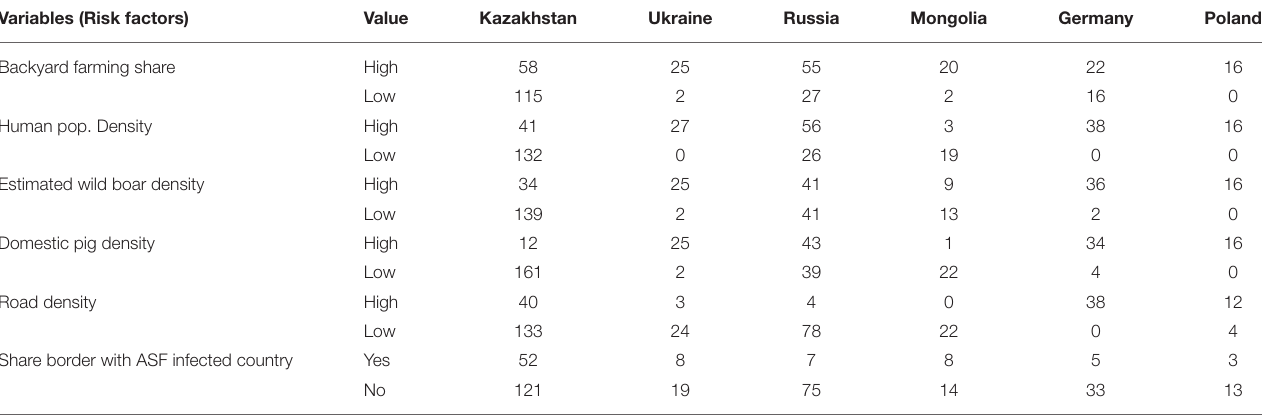
TABLE 4 | Distributions of district and regions/oblasts for the countries considered as candidate countries for model validation for predict the risk of introduction of ASF in Kazakhstan. Variables (Risk factors)